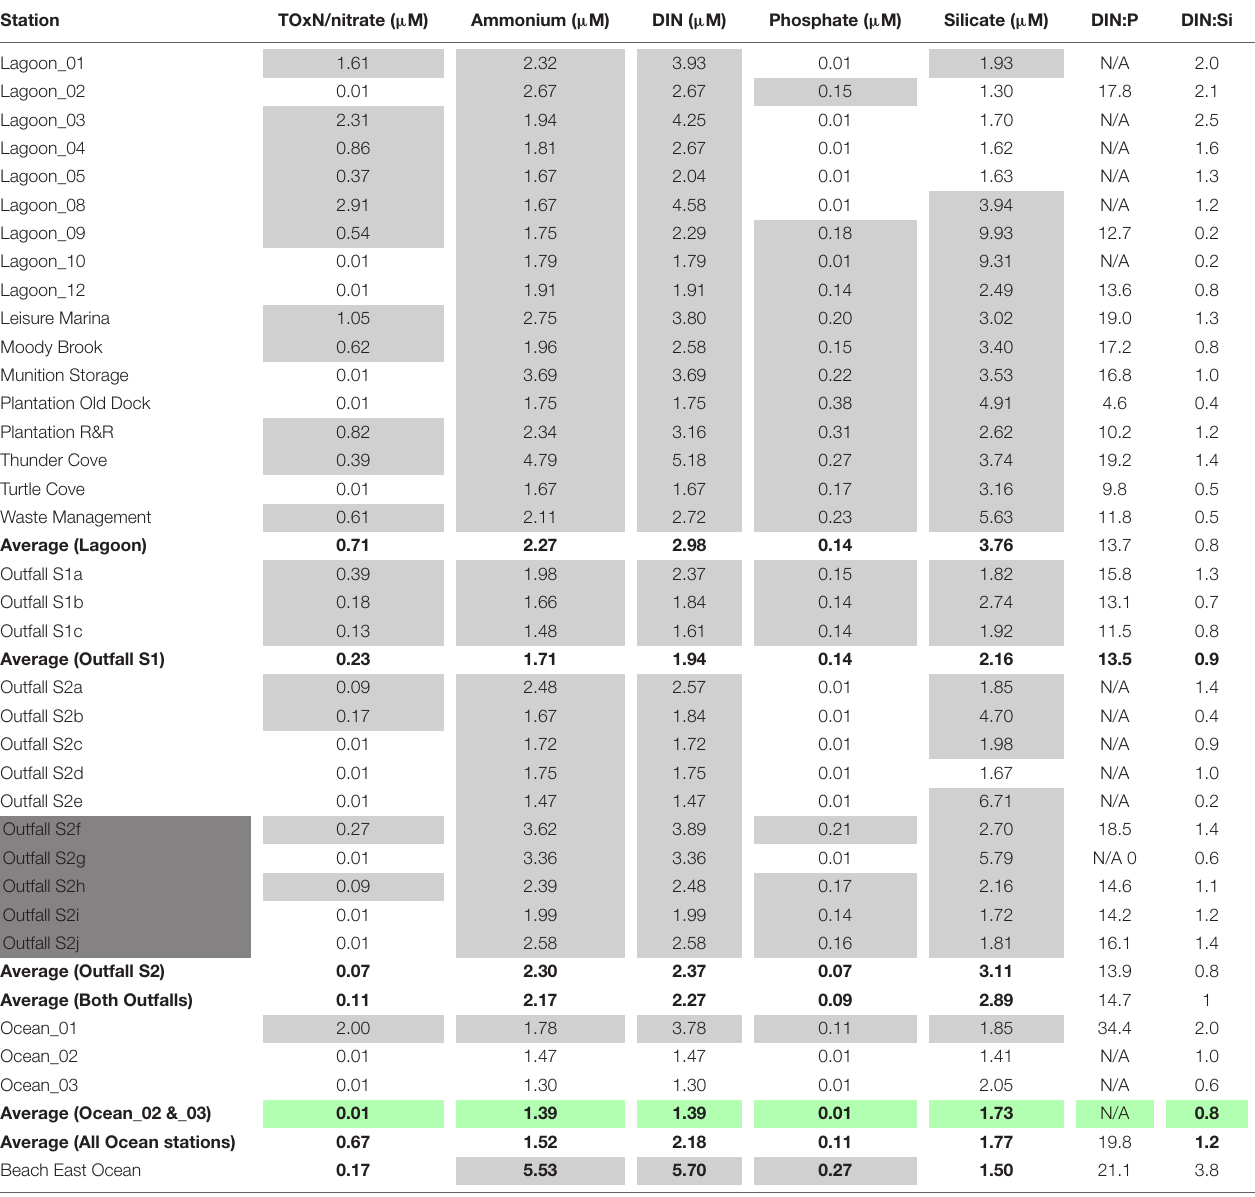
TABLE 3 | Concentrations of dissolved inorganic nutrients ( µ M) at all stations sampled.